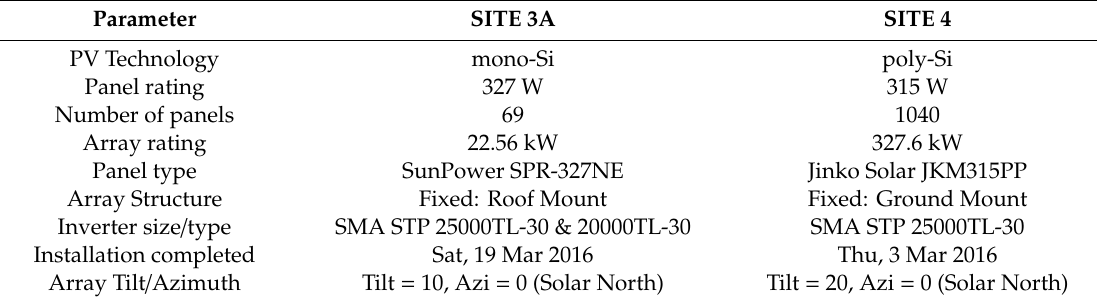
Table 1. The specific information of two systems (3A and 4).